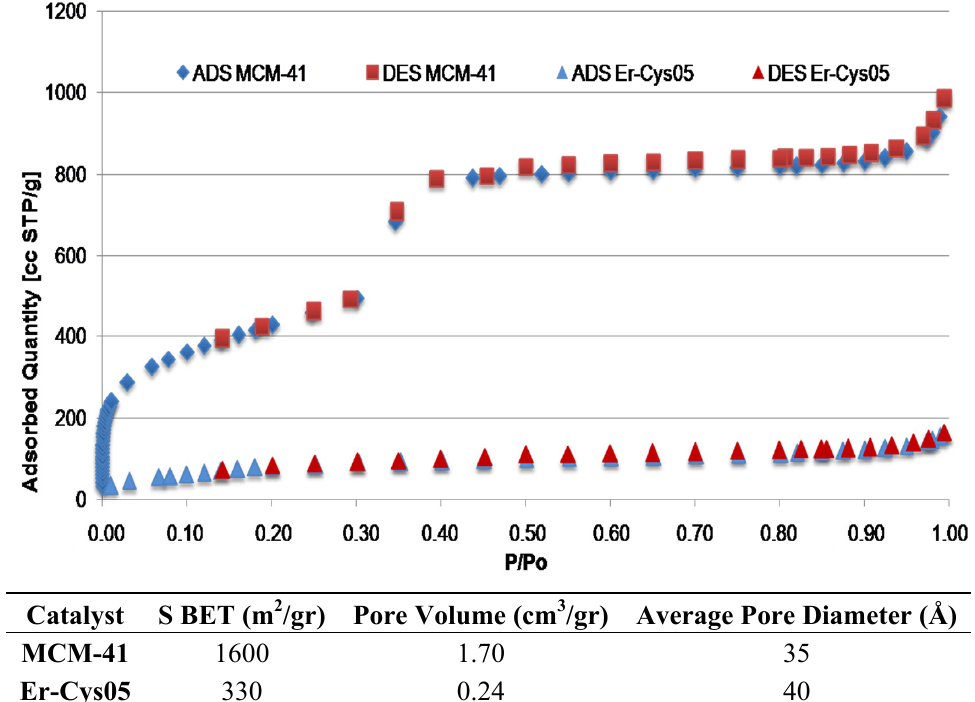
adsorption isotherms. 2